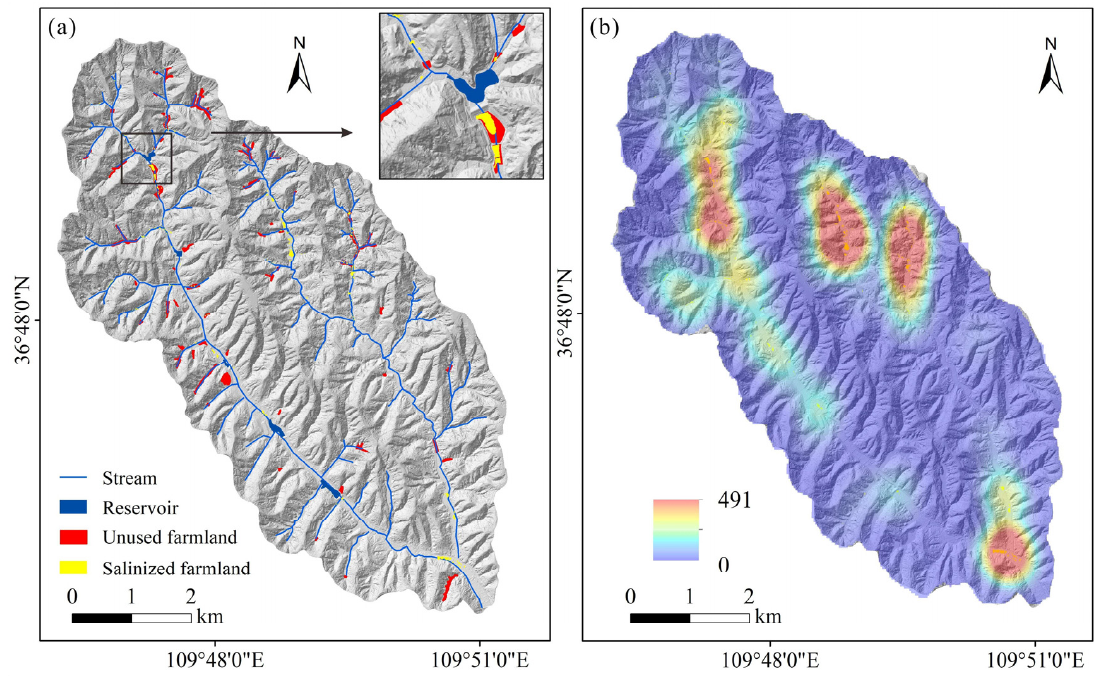
Figure 8. Spatial distribution map of salinization in the GTW. ( a ) Map of unused arable land and arable land where salt precipitate was observed in the GTW, which also includes water systems and reservoirs in the GTW; ( b ) kernel density distribution of salinized arable land in space.